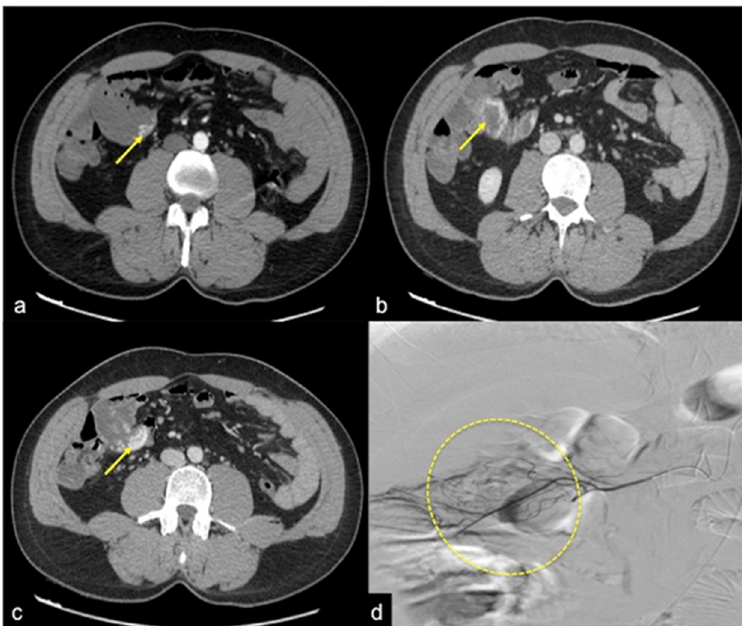
Figure 11. CTA multiphasic study of small intestine angiodysplasia. In the arterial phase ( a ) an ac- tive blush of contrast media is detected at the small bowel wall (arrow). The venous ( b ) and late ( c ) phases show a gradual increase of contrast blush (arrow ( b )) with consequent production of a haematic collection (arrow ( c )). In the selective angiography ( d ) the CTA findings are confirmed and the presence of an angiodyslastic focus is documented (discontinued circle).